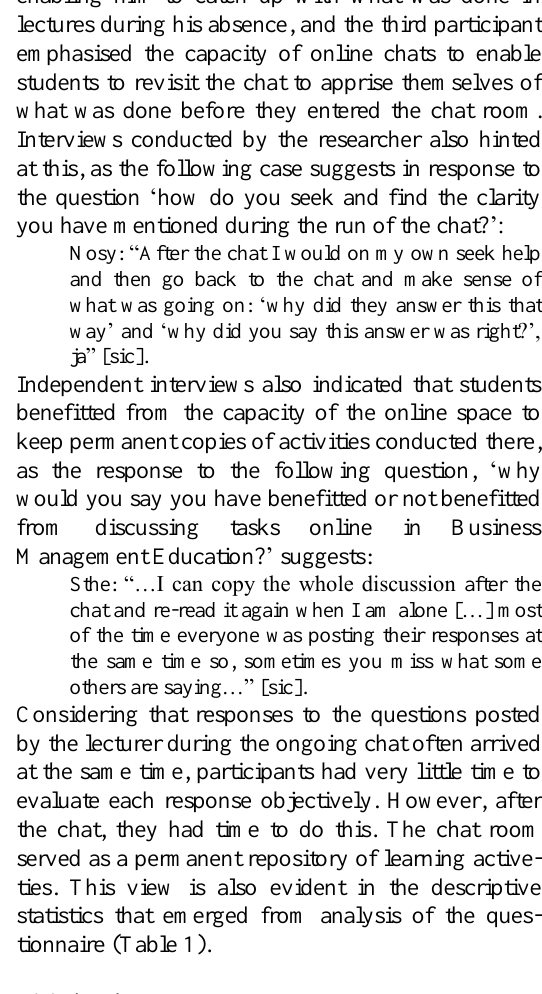
Table 1 Number of students who indicated that they could revisit the chat If I missed the chat session, I could go back to previous chats and I could learn from questions and answers